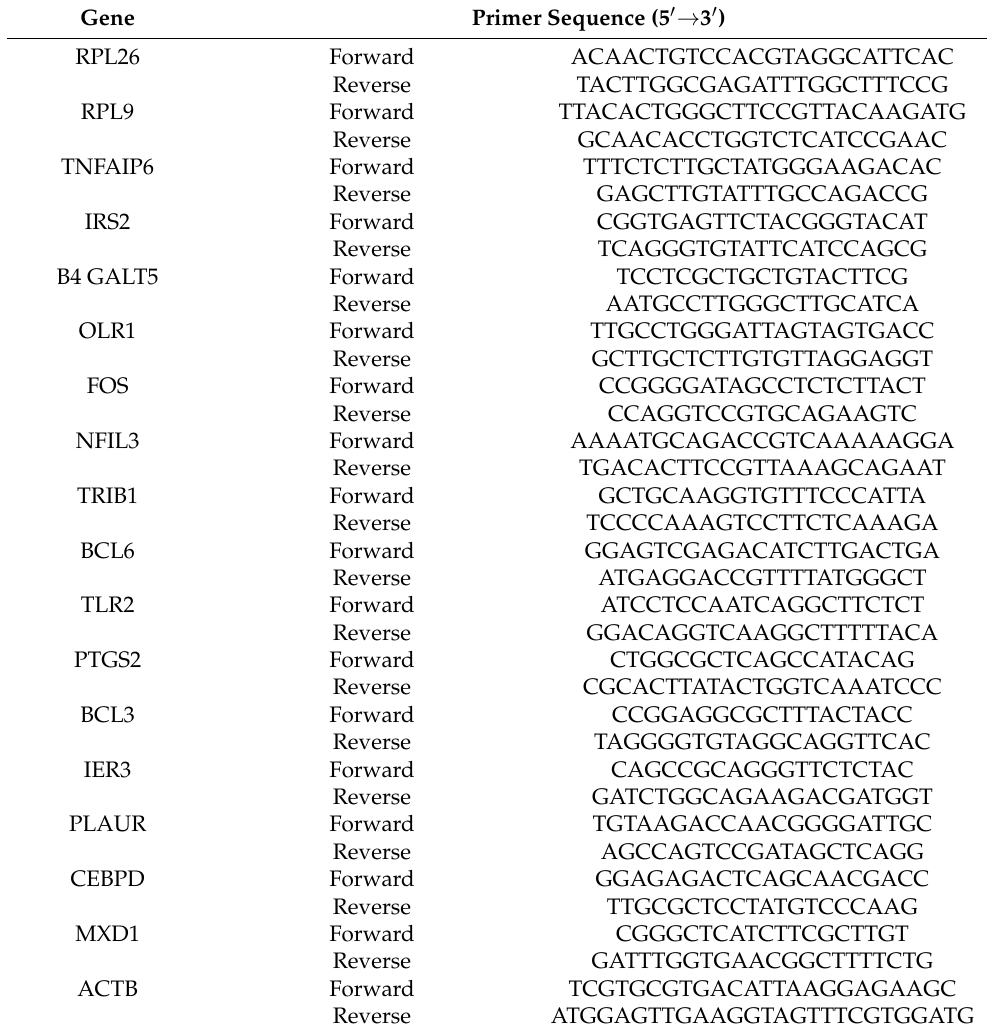
Table 1. Primer sequences for quantitative real-time PCR.